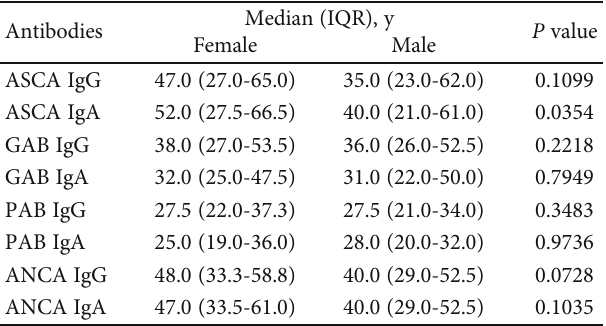
Table 3: Ages of patients with positive ASCA, GAB, PAB, and ANCA. Antibodies